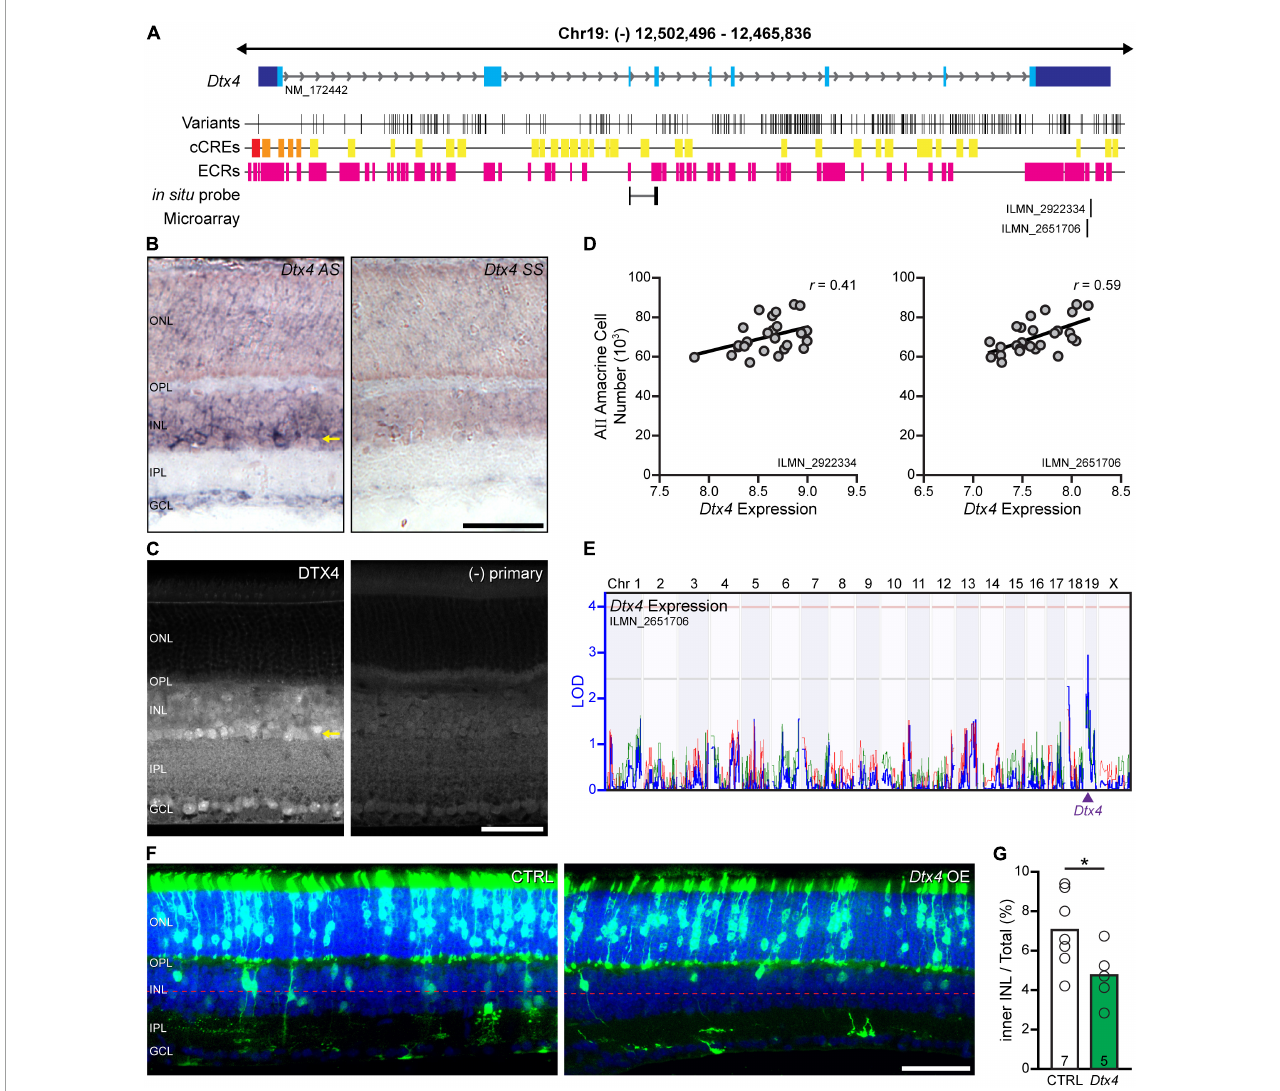
FIGURE5 Dtx4 overexpression decreases amacrine cell number. (A) The genomic structure of Dtx4 , with positions relative to the mm10 assembly and all annotated RefSeq transcripts shown. The Dtx4 gene has 9 exons and is ∼ 45 kb in size. The location of each exon is indicated (blue boxes), with the 3 (cid:48) and 5 (cid:48) UTRs in dark blue and coding sequence in light blue. The positions of each sequence variant that discriminate the A/J and B6/J genomes are indicated below, along with the location of candidate cis -regulatory elements (cCREs: red = promoter-like signature; orange = proximal enhancer-like signature; yellow = distal enhancer-like signature; green = DNase-H3K4me3 sites) annotated by the ENCODE Data Analysis Center, and evolutionarily conserved regions (ECRs). The position of the in situ hybridization probe and microarray probes are indicated along the bottom. (B) Dtx4 exhibits heightened expression in the amacrine cell layer (ACL). Expression throughout the retina is present (compare with sense probe; left) but shows greatest expression amongst the amacrine cells in the innermost portion of the INL (arrow). (C) Immunofluorescence corroborates the heightened presence of DTX4 in the ACL (arrow). (D) Microarray analysis of ocular mRNA from the recombinant inbred (RI) strains in maturity demonstrates a positive correlation with AII amacrine cell number, for both Dtx4 probes on the array. Values are normalized to mean expression across the entire microarray, with each